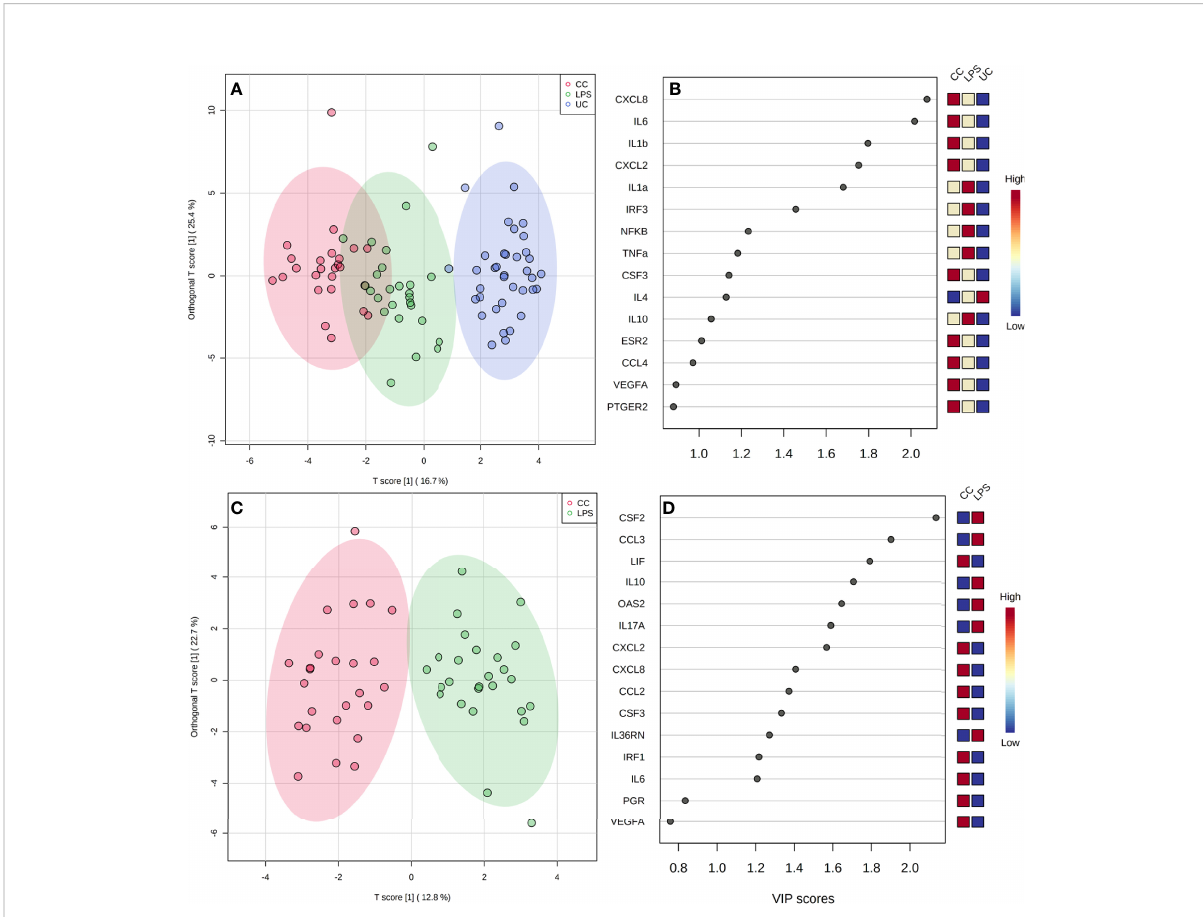
FIGURE 4 Overall gene expression clustering of explants between all treatments [ (A) ; P < 0.001], and between LPS and cultured control treatments (C) , by OPLS-DA, with corresponding VIP plots (B, D) indicating genes contributing to observed clustering. CC, Cultured Controls; LPS, Lipopolysaccharide; UC, Uncultured